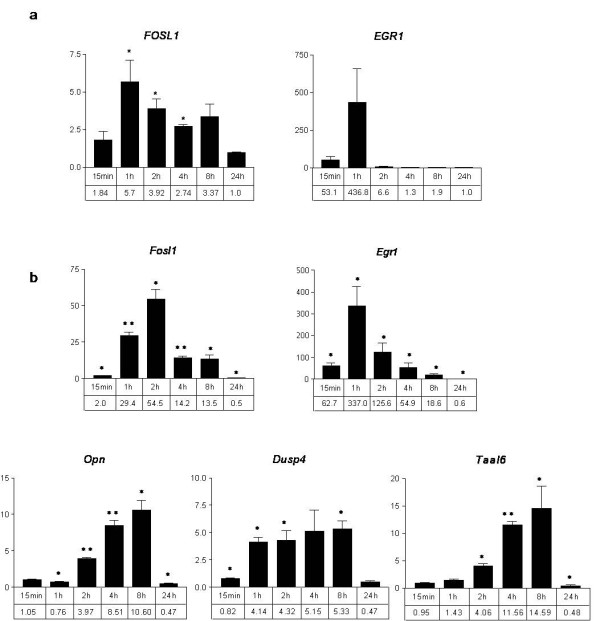
Expression of candidate genes in response to stimulation of human EGFR. Realtime PCR was performed to determine expression levels of FOSL1 and EGR1 in the human melanoma cell line A375 (a) or expression levels of Fosl1, Egr1, Opn, Dusp4, and Taal6 in HER-transgenic melan-a cells (b), stimulated with EGF for the indicated times. The fold change of transcript, referred to the unstimulated controls, is indicated on the y axis. Murine and human β-actin were used as reference genes. Significant (p < 0.05) or highly significant (p < 0.001) regulation are marked by one or two asterisks, respectively (Student's t-test, paired, two-tailed).